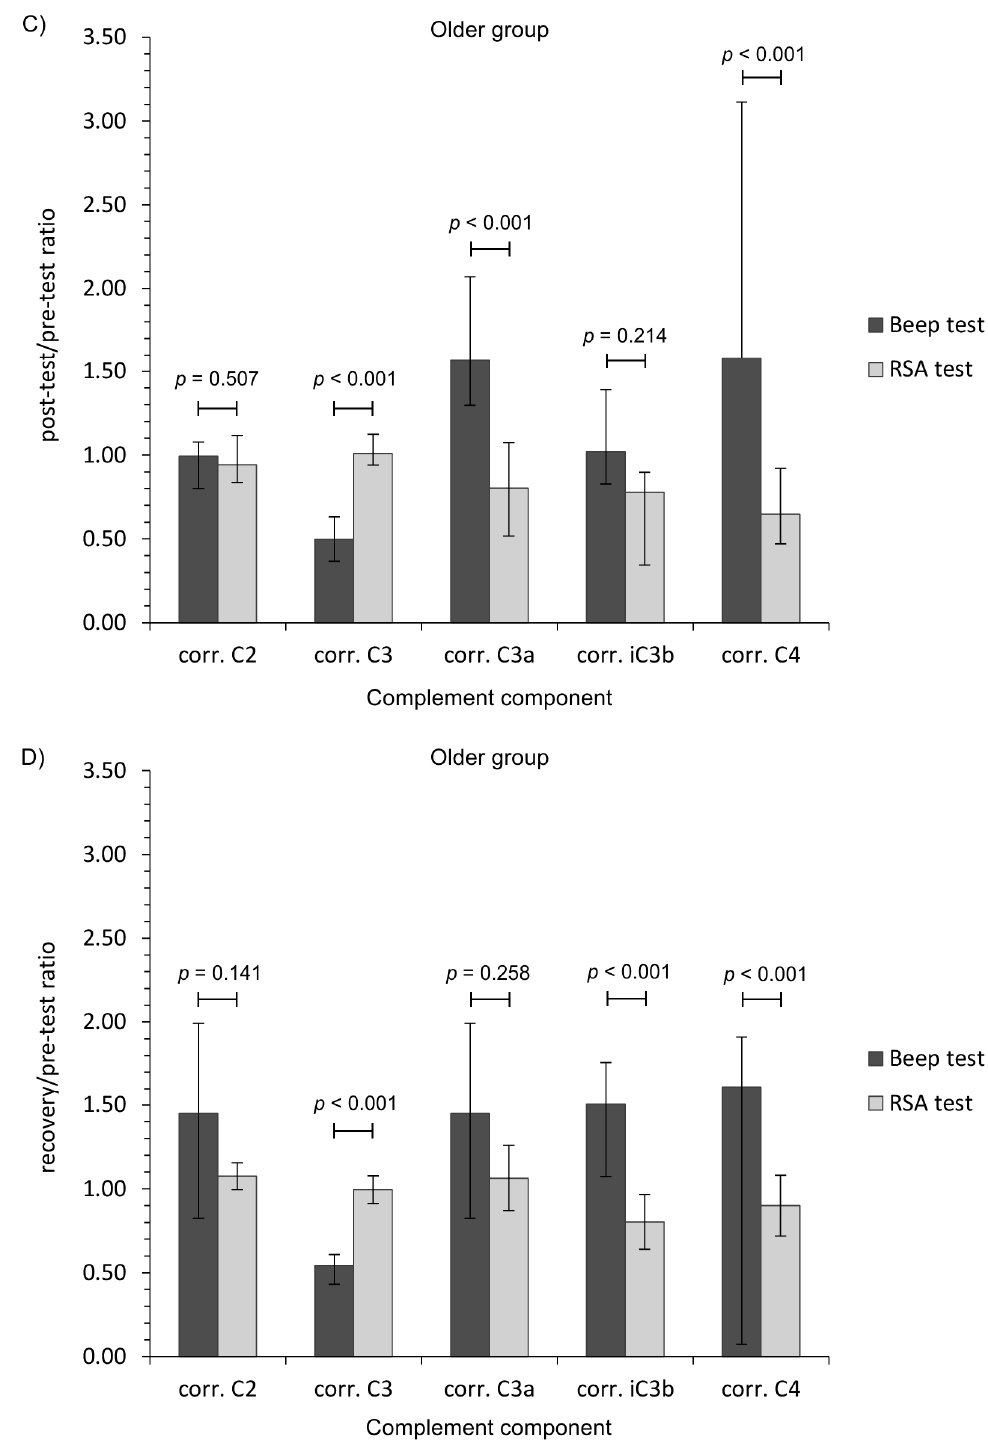
Figure 1. Ratio measures of studied complement component levels corrected for plasma volume loss after the Beep test and RSA test among studied participants. ( A ), ( C ) Post-test/pre-test values; ( B ), ( D ) recovery/pre-test values. The data are presented as median and Q1–Q3 range. Beep—maximal multistage 20-m shuttle run test, corr.—appropriate values corrected for plasma volume loss, RSA—reaped speed ability test.